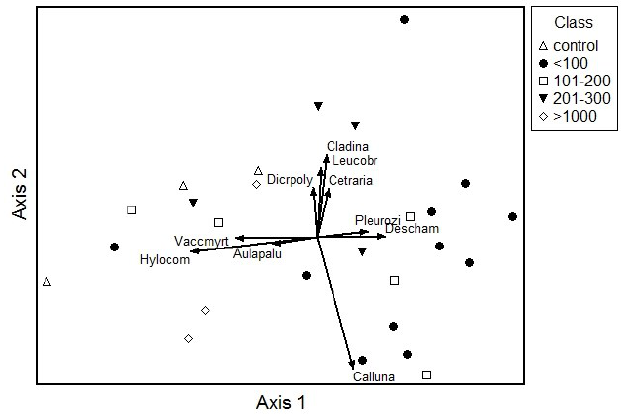
Figure 4. Species and plot scores on DCA. Gap class of plots is shown. Abbreviations: Hylocom— Hylocomium splendens ; Vaccmyrt— Vaccinium myrtillus ; Aulapalu— Aulacomnium palustre (Hedw.) Schwägr.; Melamp— Melampyrum pratense ; Dicrpoly— Dicranum polysetum Sw.; Dicrscop— Dicranum scoparium Hedw.; Cladina— Cladina rangiferina (L.) Nyl.; Leucobr— Leucobryum glaucum (Hedw.)